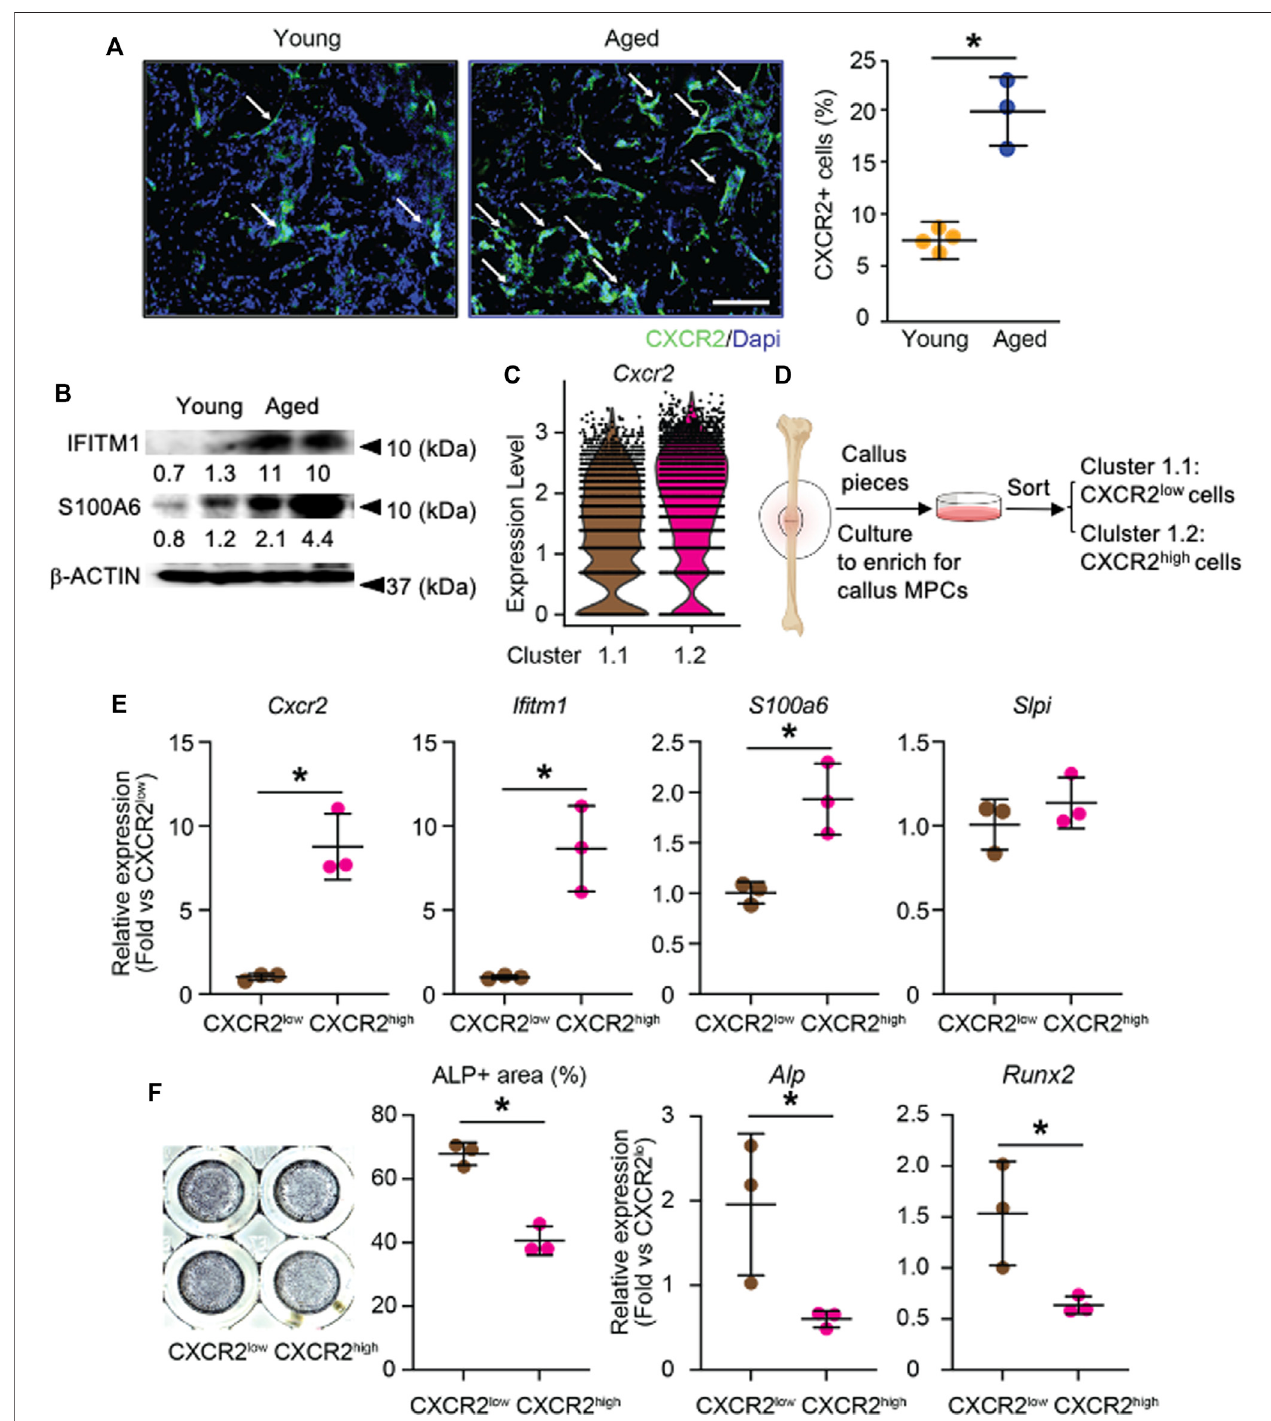
FIGURE 4 | ValidationofincreasedCXCR2 high cellsinthecallusofagedmicewithincreasedIRFandNF- κ Bpathwaysandreducedosteogenicpotential.Thetibialfracturewas performed on 4-month- (young) and 21-month-old (aged) C57BL/6J male mice and fracture callus was harvested 10 days after the procedure. (A) Immunostaining with anti-CXCR2 antibodyincallussectionsforCXCR2+cells.ImagesshownumerousCXCR2+cells(arrows)localizeonthesurfaceofwovenbone.ThepercentageofCXCR2+cellsinthecallusofyoung andagedmicewasquanti fi edbyImageJsoftware. n =4mice/youngand3mice/aged.Datarepresentmean±SD.Unpairedtwo-tailedt-test.* p < 0.05.WB:Wovenbone.Scale bar=1 mm. (B) WesternblottoassessIRF-responseproteinIFITM1andNF- κ B-responseproteinS100A6inyoungandagedcallustissues. (C) ViolinplotoftheexpressionlevelofCxcr2 incluster1.1andcluster1.2. (D) CXCR2 low andCXCR2 high cellswereisolatedfromcallus-derivedmesenchymalprogenitorculture. (E) TheexpressionlevelsoftargetgenesforIRFand NF- κ BweremeasuredbyRT-qPCR. n =3mice/group.Datarepresentmean±SD.Unpairedtwo-tailedt-test.* p < 0.05. (F) CXCR2 low andCXCR2 high cellsisolatedfromcallus-derived mesenchymal progenitor culture were cultured in osteoblast inducing medium for 7 days and stained for ALP. The percentage area of ALP+ was measured in Image J software. Expression level of Alp and Runx2 was measured with RT-qPCR. Data represent mean ± SD. Unpaired two-tailed t -test. * p < 0.05.